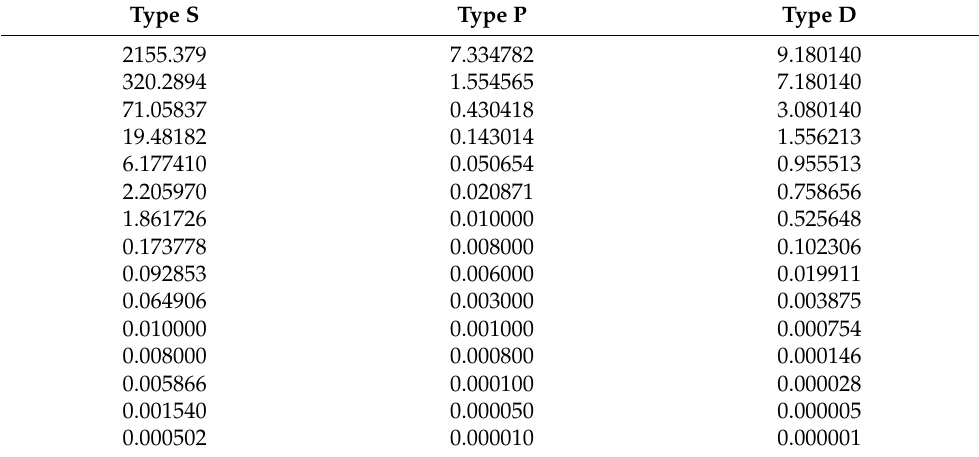
Table 1. Basis set of Cartesian Gaussian functions (CGFs) considered to describe the ground state of the Be atom and the positron scattering orbitals in this work. The CGF core was extracted from [23], and functions were added to obtain 15 of each kind. All functions are